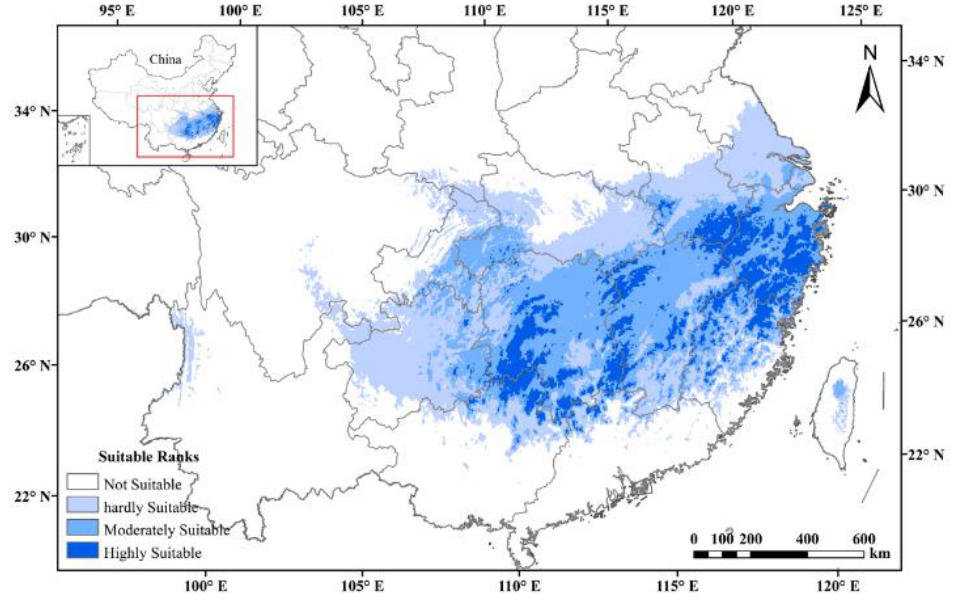
Figure 4. Potential distributions of tetraploid A. chinensis under current climatic scenarios in China.